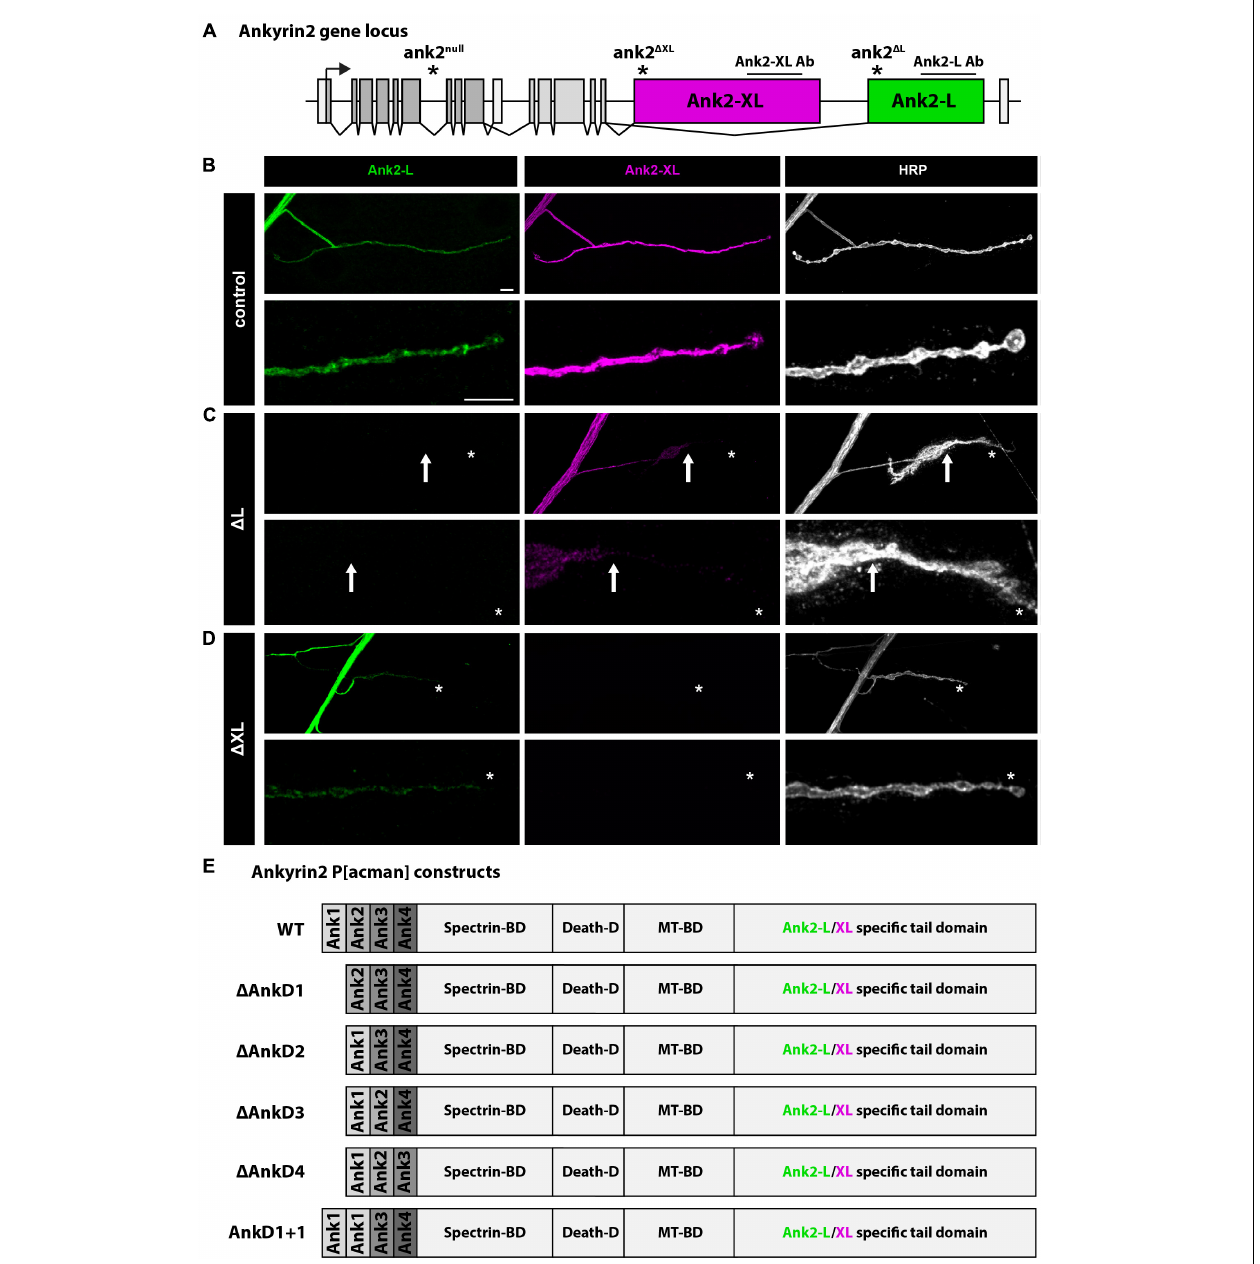
FIGURE 1 | Analysis of Ank2-L and Ank2-XL. (A) Schematic of the Drosophila ank2 genomic locus. The position of the ank2-L and ank2-XL specific exons and the positions of the specific mutations and antibody epitopes are indicated. (B) Analysis of Ank2-L and Ank2-XL distribution in control animals. Both proteins are present in all synaptic regions demarcated by the neuronal membrane marker HRP. (C) In ank2 (cid:49) L ( (cid:49) L) mutant animals Ank2-L is completely absent and a severe perturbation of synaptic Ank2-XL distribution and levels can be observed. Ank2-XL is no longer present in distal boutons (arrow, asterisk). (D) In ank2 (cid:49) XL ( (cid:49) XL) mutant animals Ank2-XL is absent. Ank2-L levels are reduced but the presynaptic distribution is not perturbed (asterisk). (E) Schematic overview of the P[acman] constructs used to analyze the contribution of different parts of the ARD for Ank2-L and Ank2-XL localization and function. Each AnkD region includes six ankyrin repeats. Scale bars in (B) apply to (B–D) and represent 10 µ